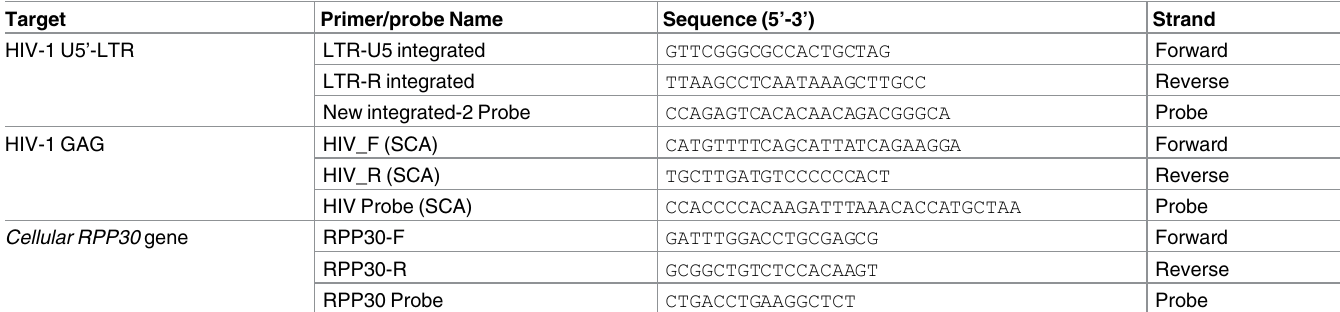
Table 1. Primers and probes used for vDNA quantification.